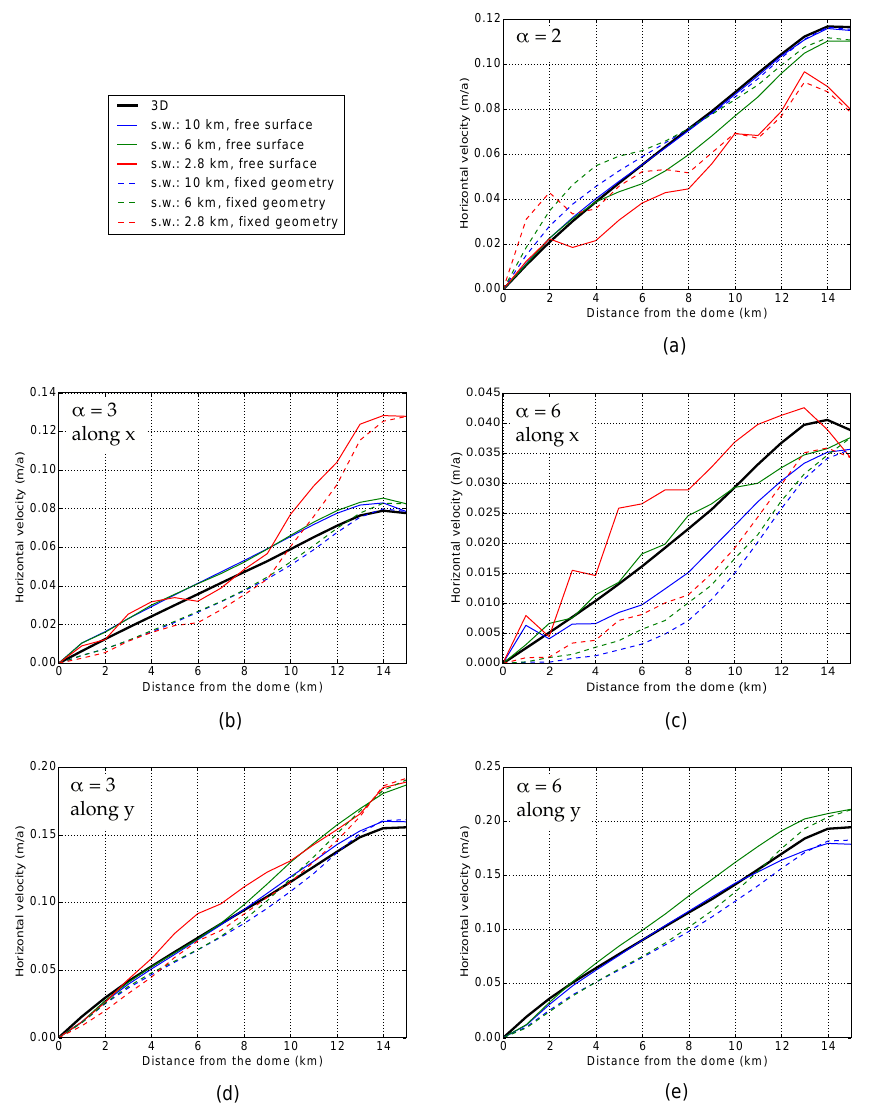
Figure 4. Horizontal velocity at the ice surface (ma − 1 ) along the flowline, for isothermal ice. Dashed lines are for fixed geometry runs and solid lines for evolved free surface to a steady state. Thick black: 3-D; yellow: 2.5-D axisymmetric (hidden by the black curve); red: 2.5-D scanning window of 2.8km; green: 2.5-D scanning window of 6km; blue: 2.5-D scanning window of 10km. (a) Circular dome, α = 2. (b) α = 3, along the ridge. (c) α = 6, along the ridge. (d) α = 3, perpendicular to the ridge. (e) α = 6, perpendicular to the ridge. For this last case, no result concerning the 2.8km scanning window is shown, since they are completely out of reasonable